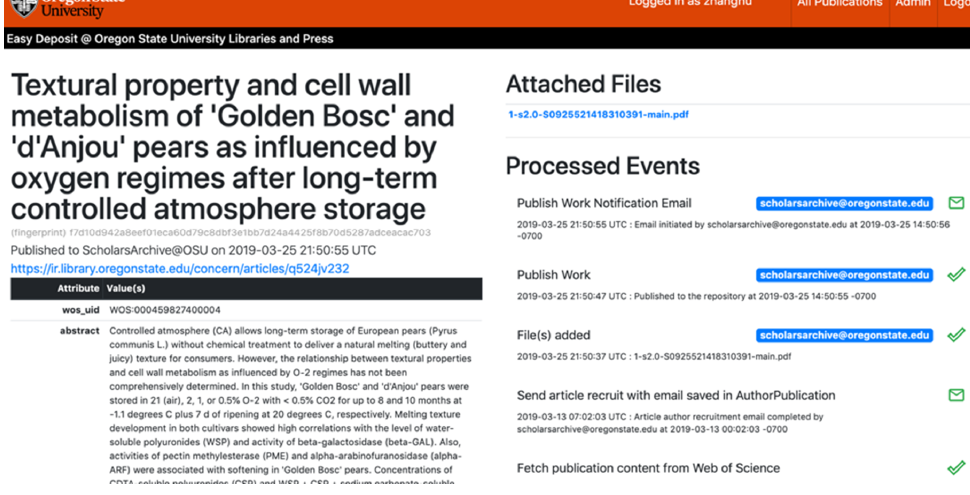
Figure 2. Demonstration of Easy Deposit 2 (ED2) deposit page with a randomly selected article.